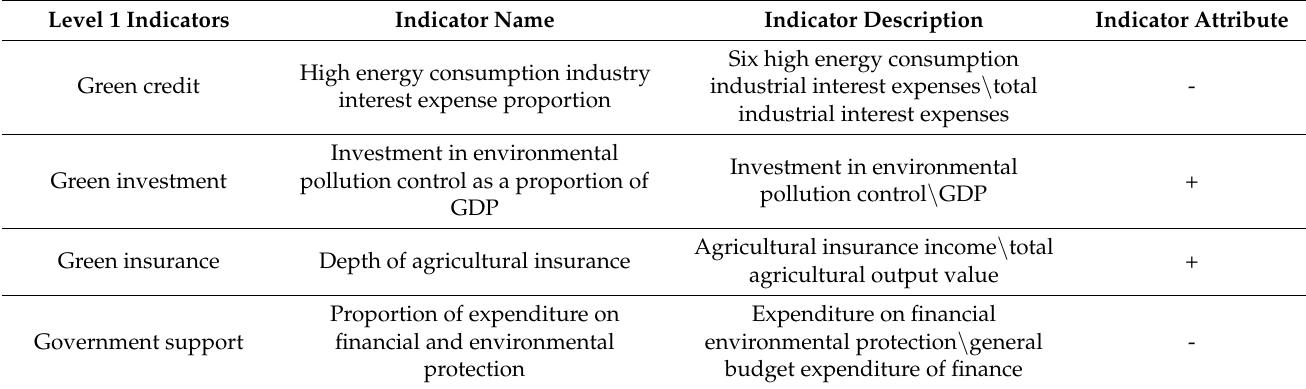
Table 3. Level 1 indicators of the green financial indicator